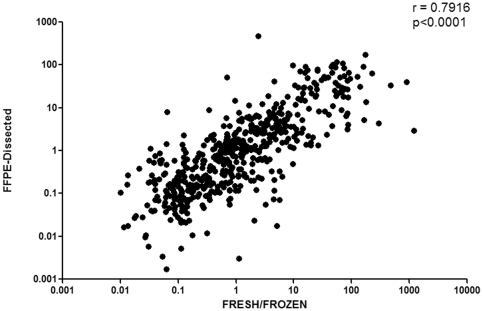
Scatter plot showing Spearman correlation between Fresh/Frozen and FFPE-dissected groups.